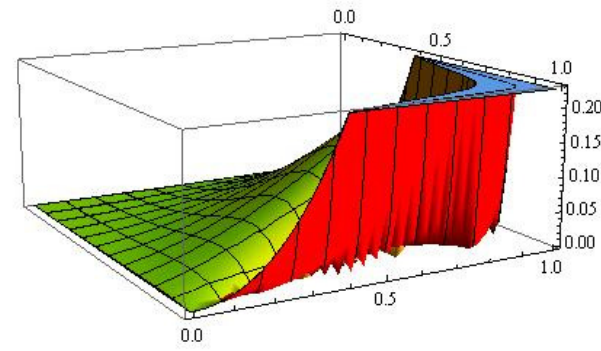
Figure 4. Graphical representation of